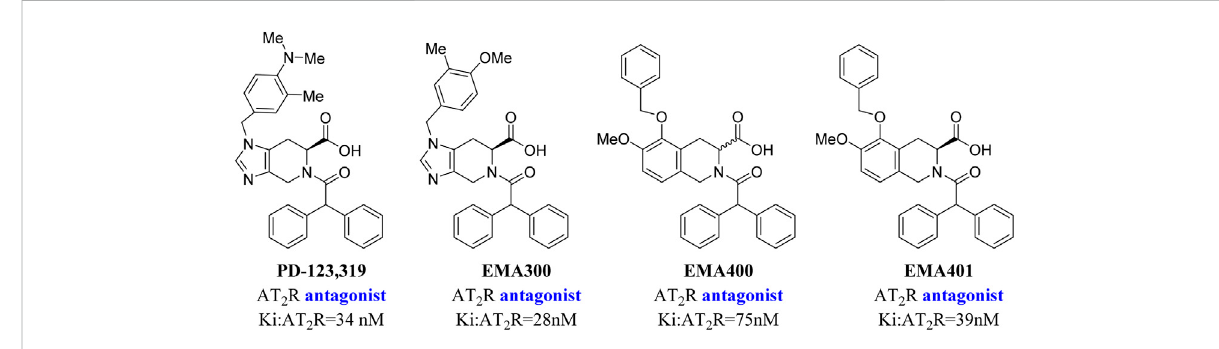
FIGURE 5 AT 2 receptor antagonist with the tetrahydroisoquinoline structure.